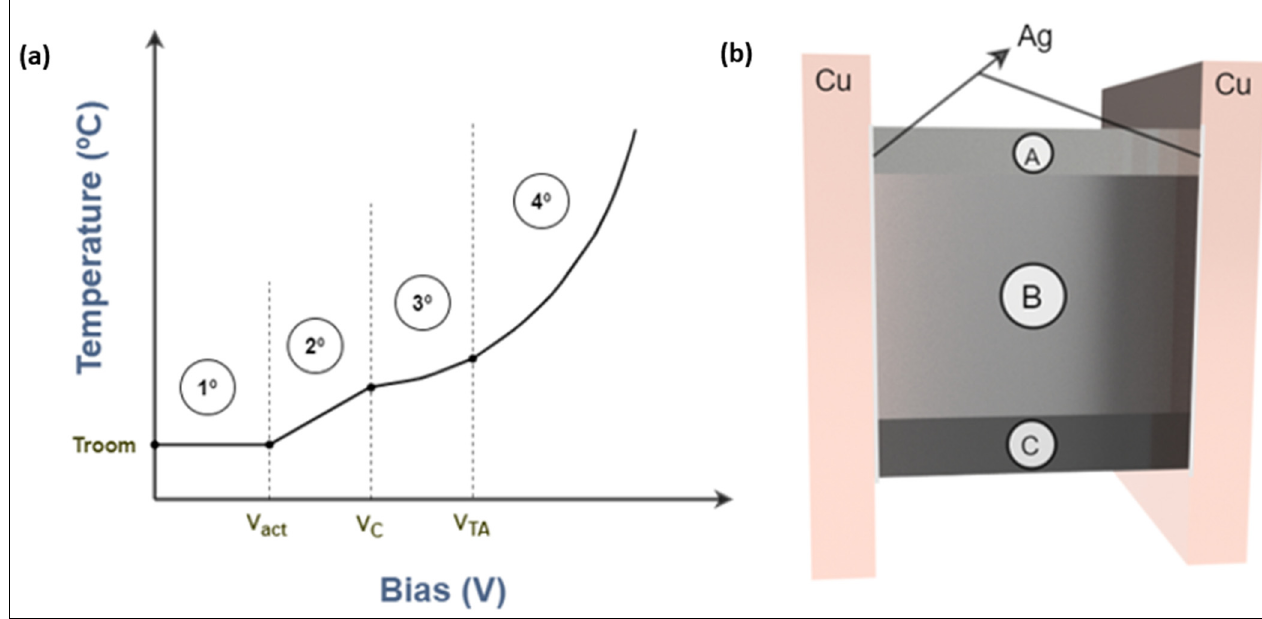
Figure 11. General temperature tendency graph with the different stages ( a ) and scheme of nanomaterial with different sedimentation zones ( b ). It is possible to observe the three characteristic voltages that represent the change of trend ( V act , V C , V TA